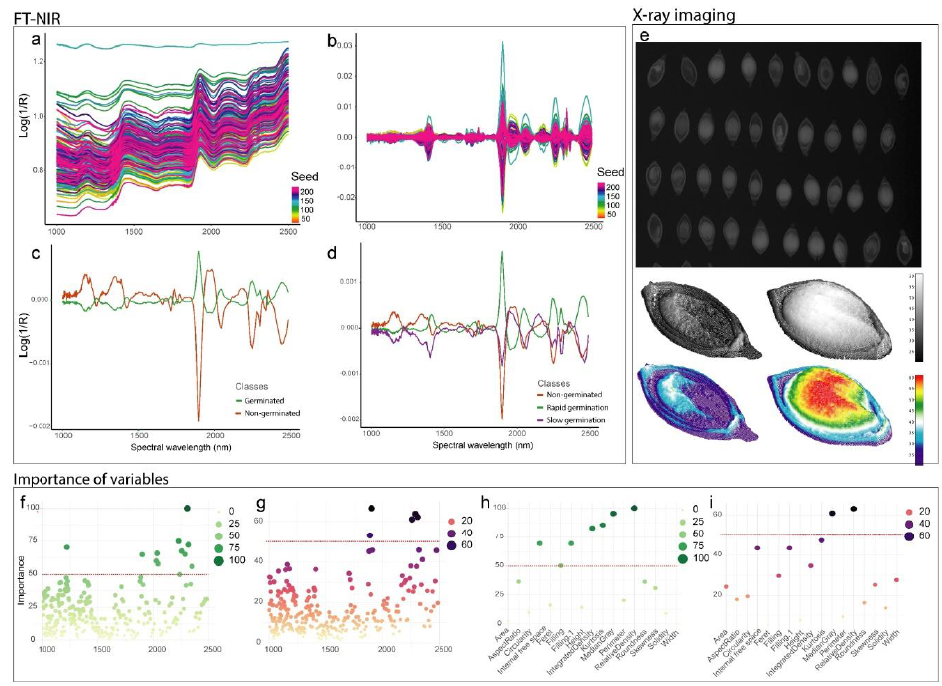
Figure 1. Quality classification of U. brizantha seeds based on Fourier transform near-infrared (FT-NIR) spectroscopy and X-ray imaging: ( a ) raw NIR spectra; ( b ) spectra preprocessed to establish predictive bands and reduce the e ff ect of noise; ( c ) mean spectra for classes of germination capacity and ( d ) seed vigor; ( e ) X-ray images and 3D projections of seeds based on grayscale; ( f ) importance of wavelengths in FT-NIRbasedonthePLS-DAmodelforclassesofgerminationcapacityand( g )seedvigor; ( h )importance of X-ray image descriptors based on the LDA model for classes of germination capacity; and ( i ) PLS-DA model for classes of seed